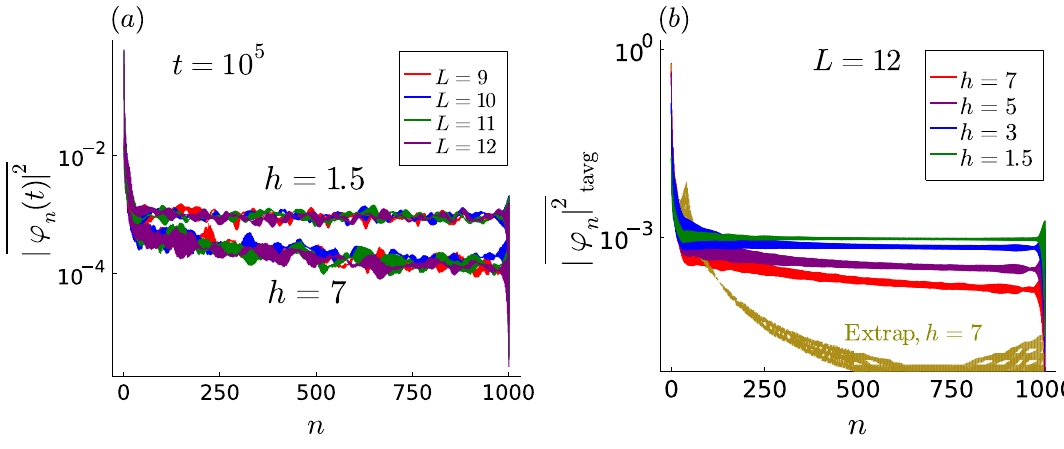
( t ) | 2 at t = 10 5 in the n